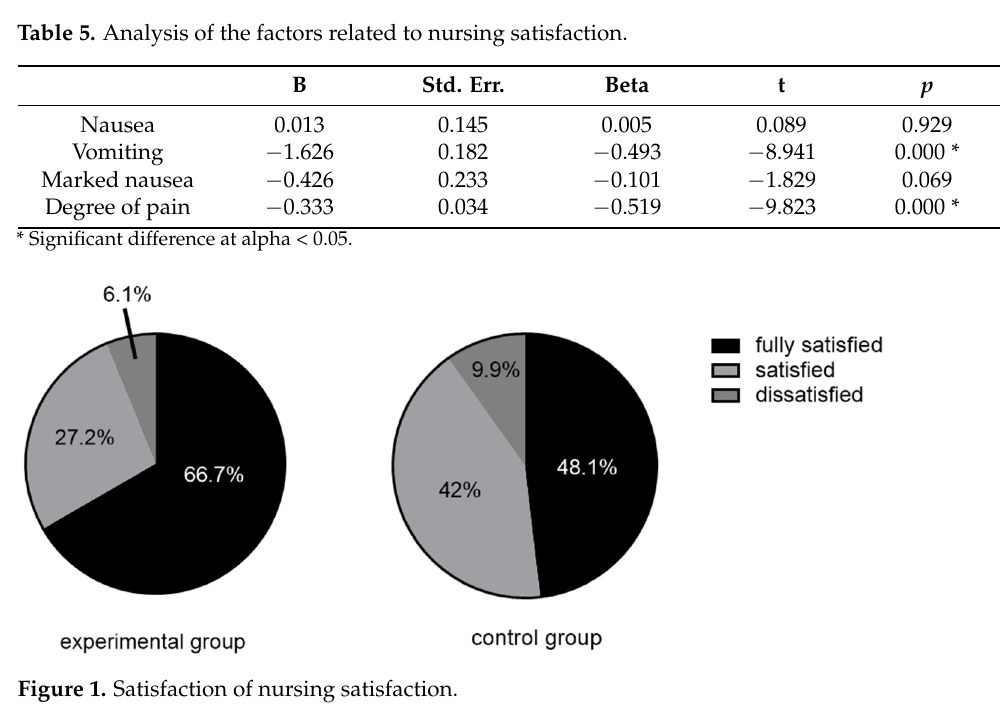
Figure 1. Satisfaction of nursing